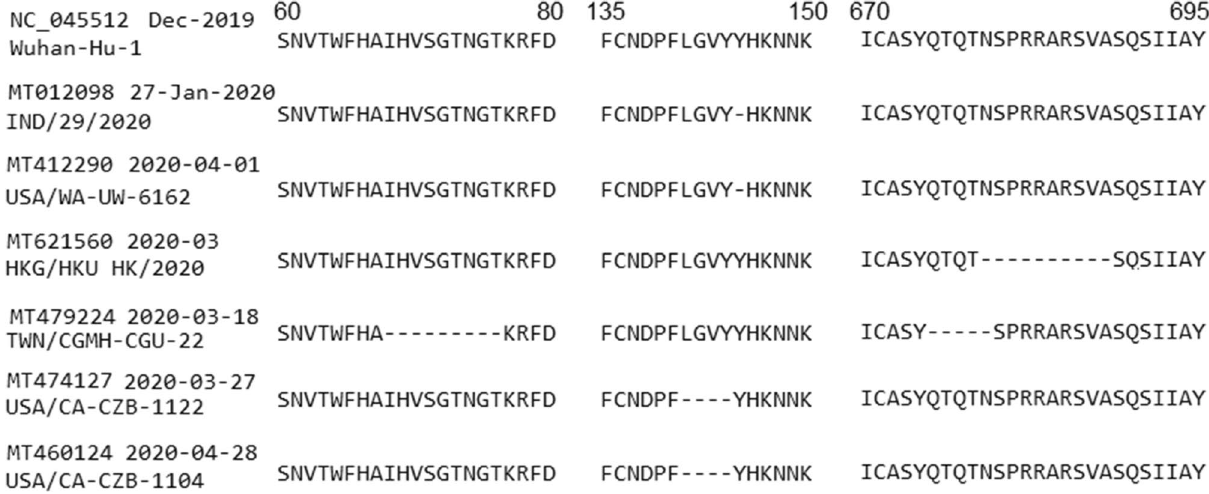
ratio between nonsynonymous versus synonymous mutations at 5.54. Among the nonsynonymous mutations, mutation D614G is extremely common as it happens in 3089 sequences, majorly collected in USA (2340), India (210) and Australia (132). The first collected date of the D614G mutation cannot be identified precisely because some sequences deposited to the NCBI GenBank did not record the full date details. The current data show that either of the following sequences, which have the D614G mutation, was first collected: MT326173 in USA in 2020, or MT270104, MT270105, MT270108 and MT270109 all in Germany: Bavaria in 2020-01, or MT503006